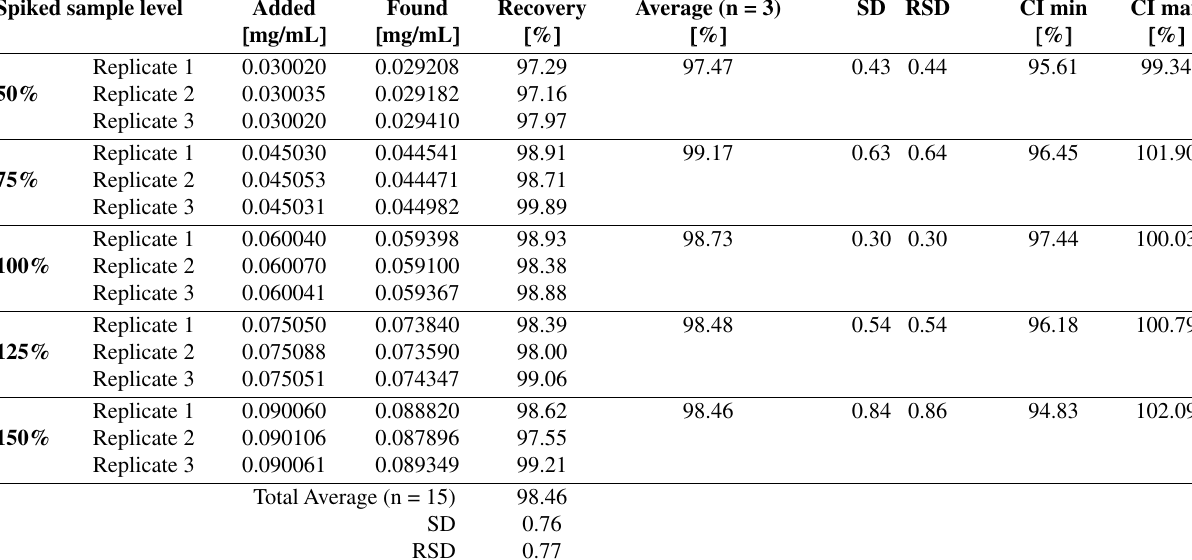
Table 8. Results of recovery experiments at five concentration levels of BKC, obtained with optimized HPLC method. Spiked sample